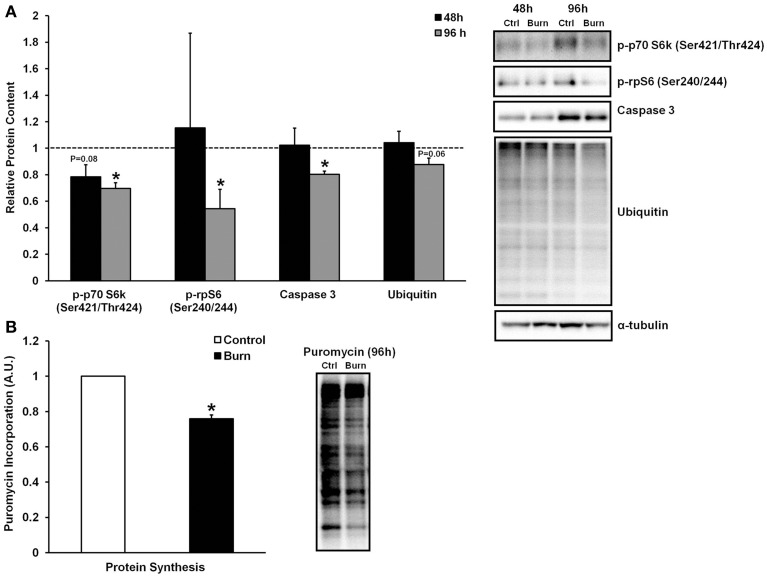
Effects of burn serum on anabolic/catabolic signaling (A) and protein synthesis measured via the SUnSET method (B). *Different from control at respective time point; P < 0.05. Dotted line represents control values.